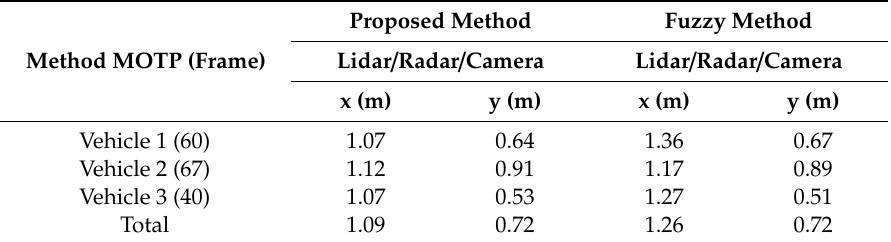
Table 5. Comparison of the results of the proposed method with fuzzy method in Scenario